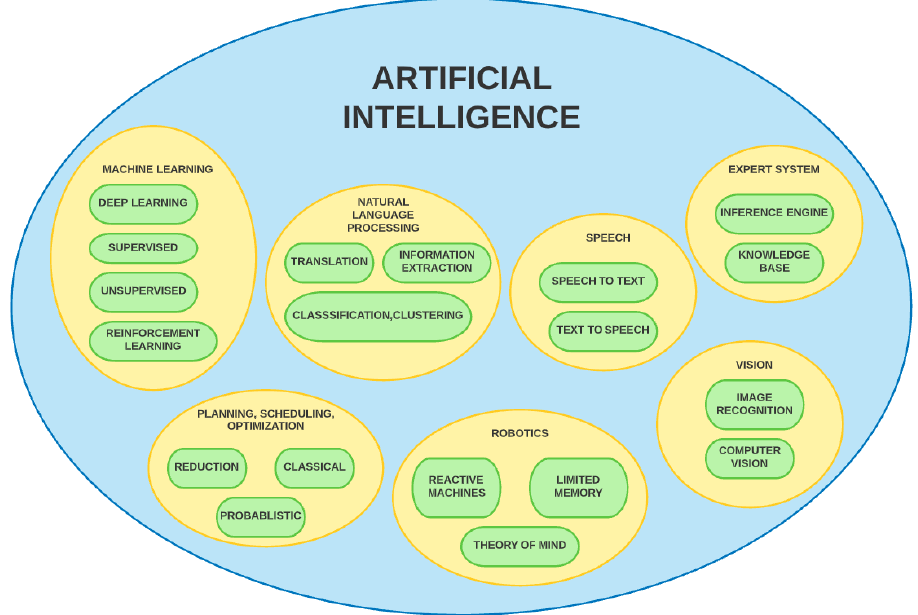
Figure 1. General taxonomy–artificial intelligence techniques.